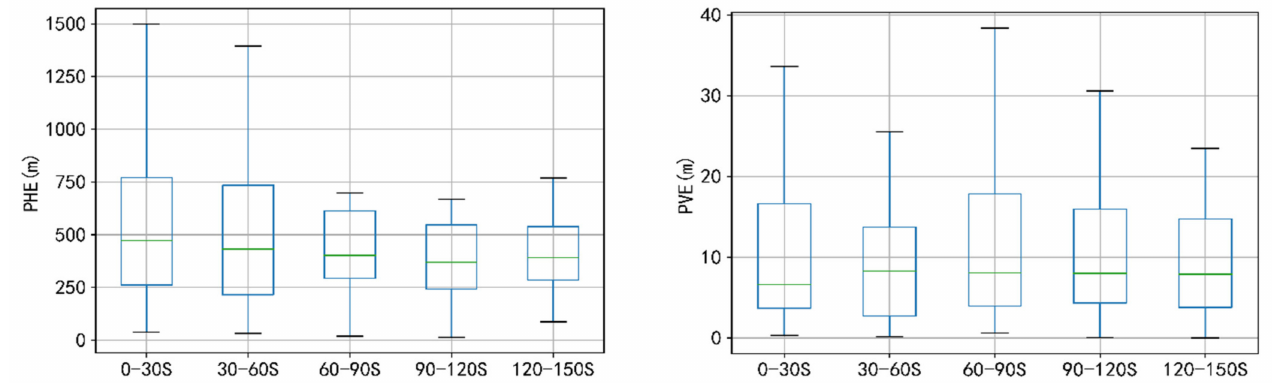
Figure 7. Box plots of different evaluation indicators for departure